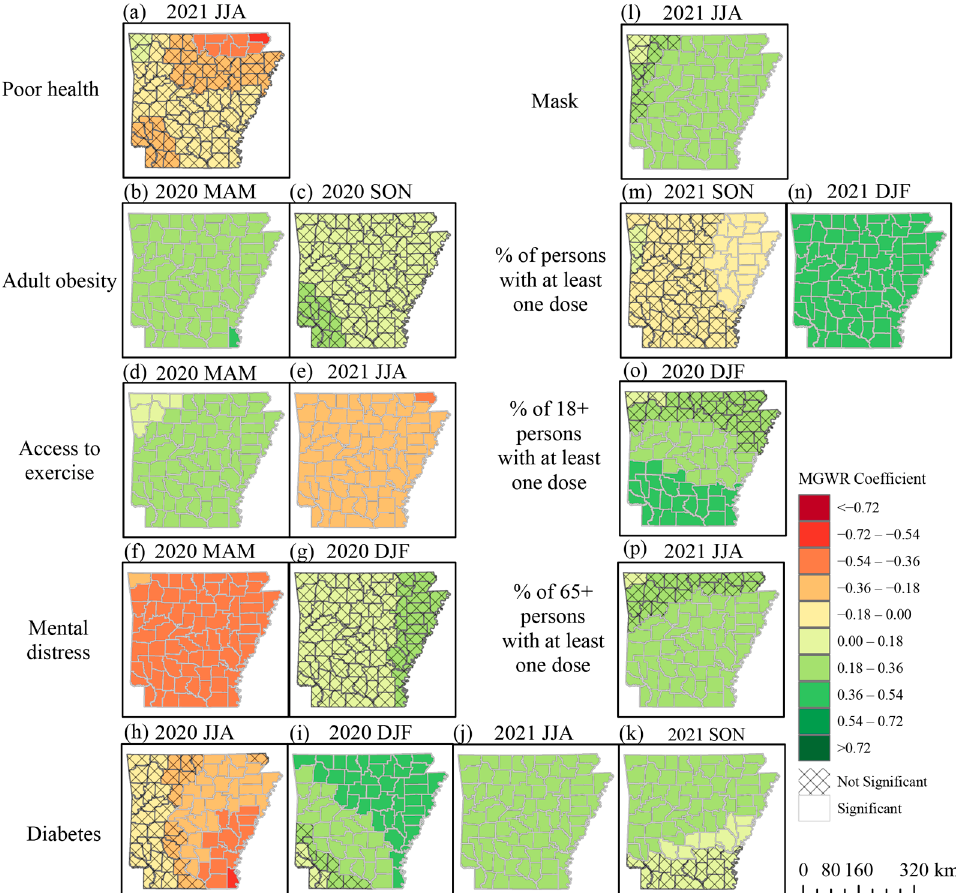
Figure 5. Spatial impacts of health variables on the COVID-19 rate derived from a multiscale geographically weighted regression model in each county in Arkansas, US from 2020 to 2021. The unhatched regions indicate a 5% significance level. (MAM: March–April–May; JJA: June–July–August; SON: September–October–November; DJF: December–January–February).